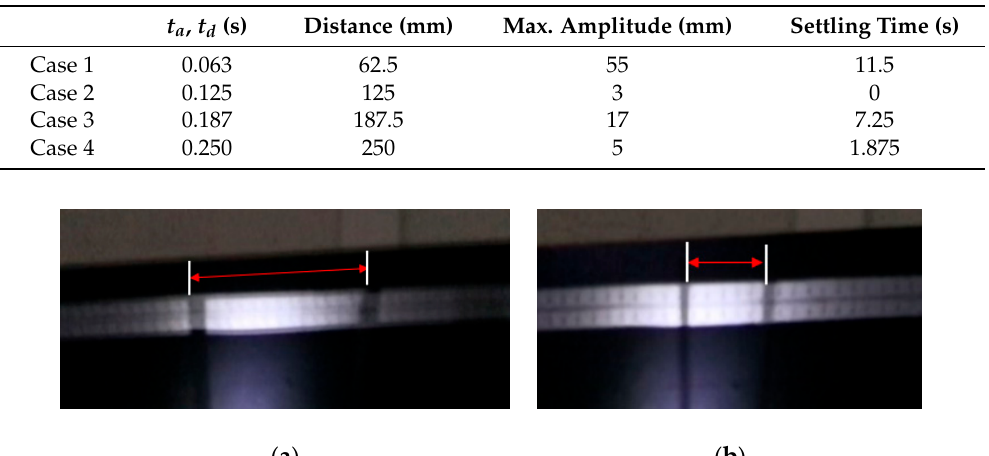
Figure 14. The velocity profiles when moving a short distance with a maximum velocity of 1000 mm/s. Table 3. Experimental results for maximum amplitude and settling time when moving a short distance with a maximum velocity of 1000 mm/s.